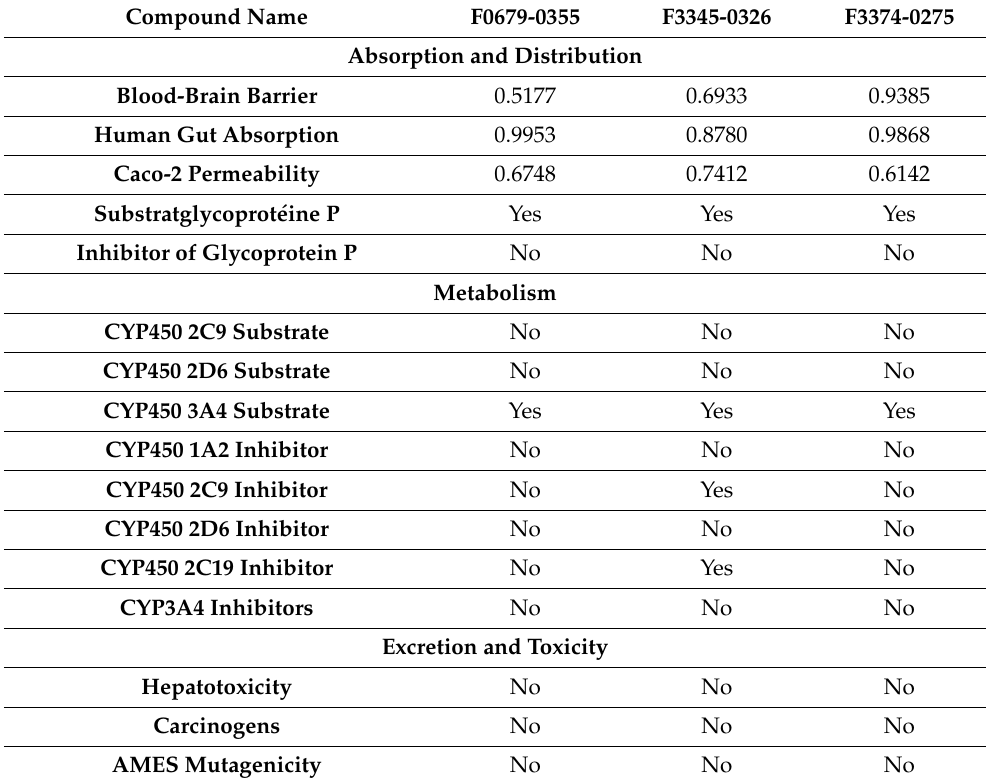
Table 2. Analysis of the pharmacokinetic properties and toxicity of the three candidate